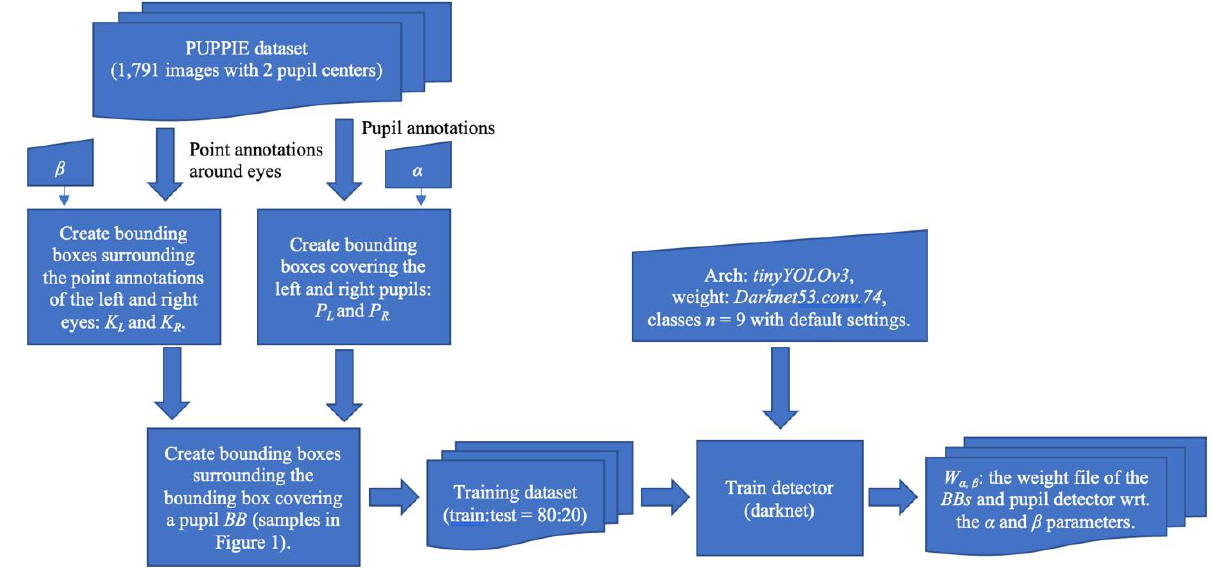
Figure 2. Summary of the details of the dataset preparations for training the